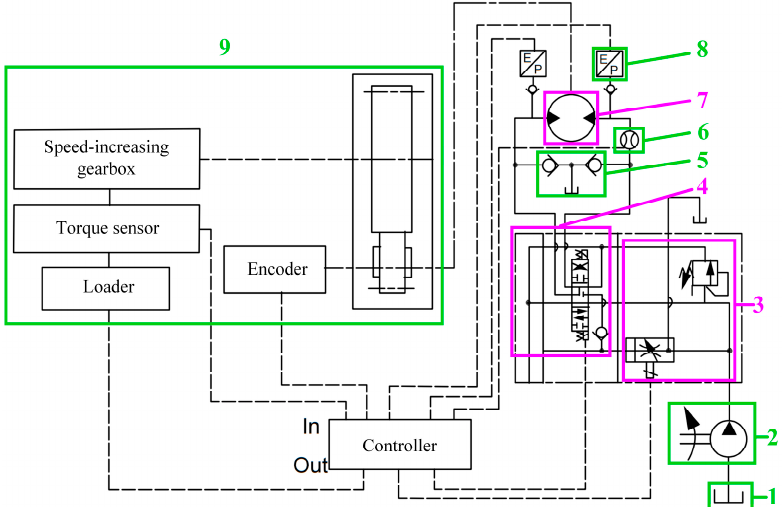
Figure 2. Schematic diagram of sail slewing hydraulic testbed. 1. oil tank; 2. hydraulic pump; 3. speed regulating valve; 4. reversing valve group; 5. balance valve group; 6. flow sensor; 7. hydraulic motor; 8. pressure sensor; 9. load module.